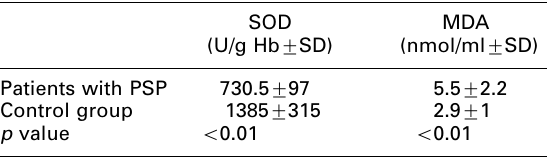
Table 1. SOD and MDA levels in the control group and in patients with PSP SOD (U/g Hb 9 / SD) Patients with